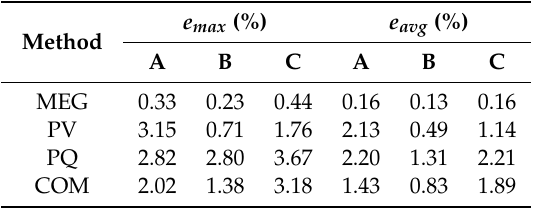
Table 5. Absolute errors of di ff erent models in Scenario